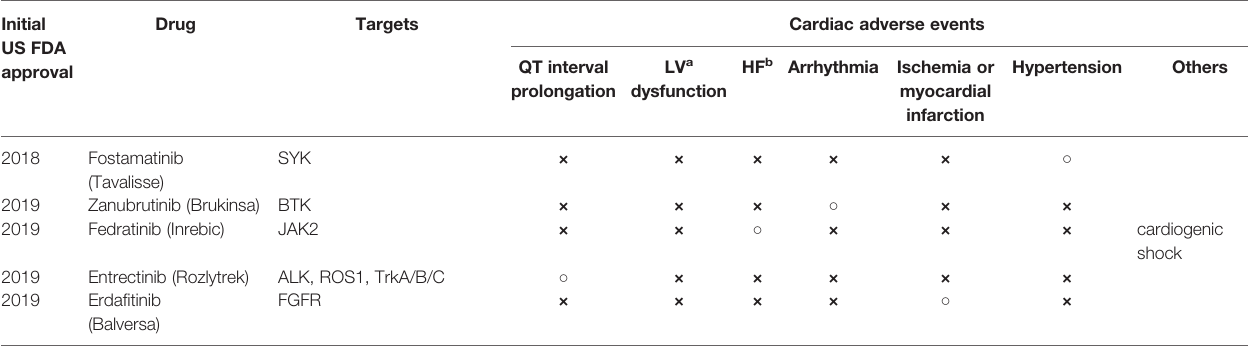
ACK1, activated cdc42-associated kinase 1; ALK, anaplastic lymphoma kinase; AXL, a tyrosine-protein kinase receptor from myeloid leukemia cells; BCR-ABL: breakpoint cluster region- Abelson fusion protein; BTK, Bruton's tyrosine kinase; CDK, cyclin-dependent kinase; c-Fms, transmembrane glycoprotein receptor tyrosine kinase; c-KIT, cellular membrane